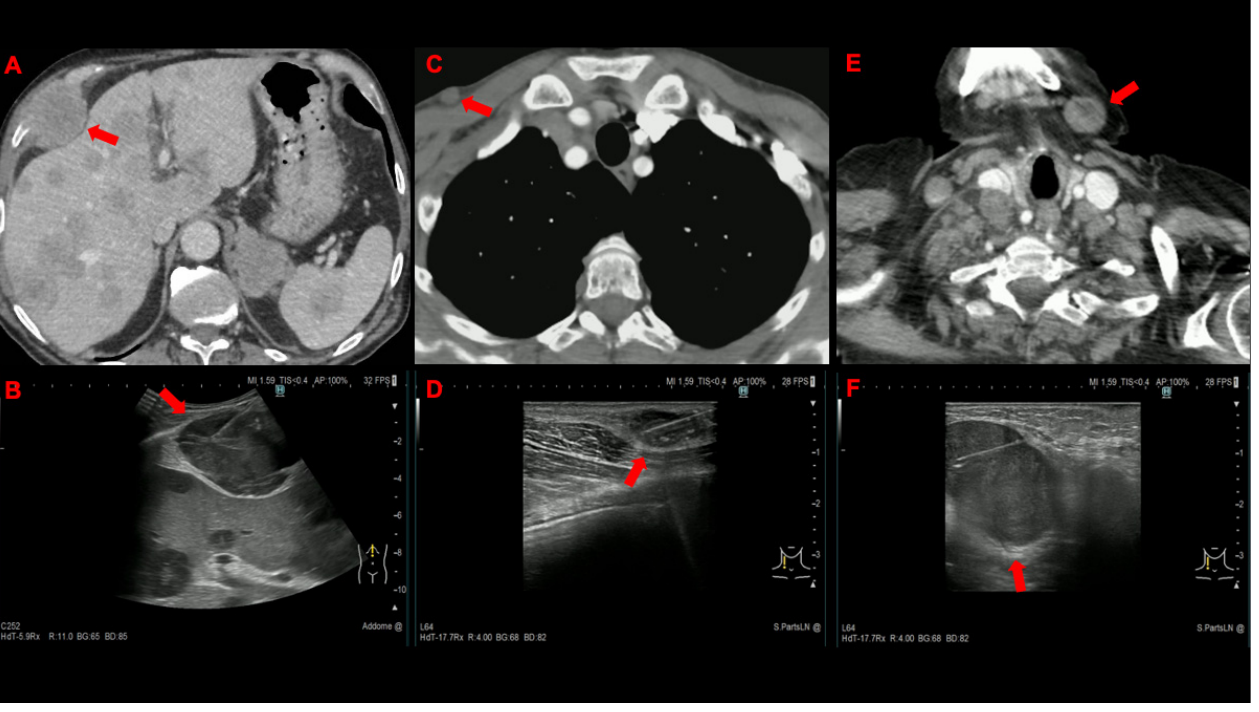
Figure 2. Contrast-enhanced CT ( A ) and corresponding US-NAB image ( B ) showing a large thoracic wall lesion (red arrow) adjacent to the liver, which contains multiple nodular lesions consistent with metastases; contrast-enhanced CT ( C ) and corresponding US-NAB image ( D ) showing a sub-centimetric subcutaneous nodule (red arrow) in the anterior aspect of the right hemithorax; and contrast-enhanced CT ( E ) and corresponding US-NAB image ( F ) from an enlarged, round cervical lymph node (red arrow).